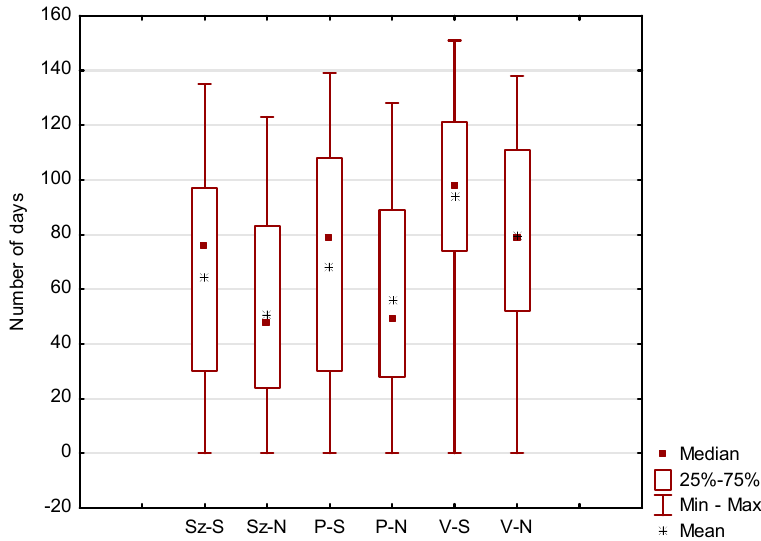
Figure 3. Box and whisker plots, presenting descriptive measures for ice season duration (S) and the number of days with ice (N) on Szczecin Lagoon (Sz–S and Sz–N, respectively), Puck Lagoon (P–S and P–N, respectively), and Vistula Lagoon (V–S and V–N, respectively) through the period 1950/51–2019/20. Boxes indicate the positions of the lower and upper quartile, and whiskers represent the maximum and minimum values of ice parameters.